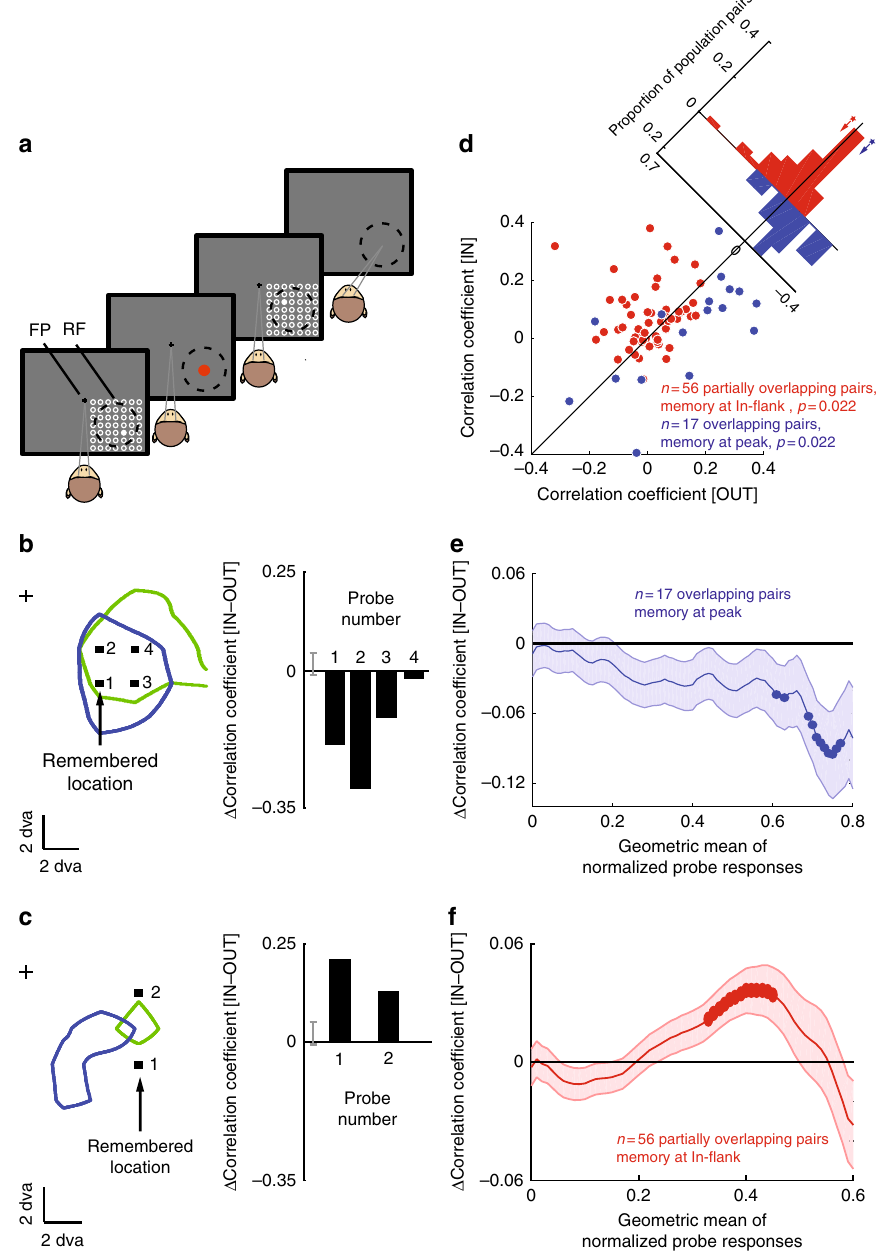
Fig. 4 Changes in noise correlations of visual responses during WM. a MGS task with visual probes. The task was the same as the regular MGS task, except that brief (200 ms) visual probes fl ashed on screen during both the fi xation and delay periods. b Changes in noise correlations of visual responses for an example pair of neurons with overlapping RFs. RF pro fi les (green and blue), probes (black squares), and WM location are shown in visual space relative to the fi xation point (cross). All four probes and WM locations were presented at the Peak location. Bar graphs indicate change in noise correlation (IN – OUT) for the four visual probe locations; for all four probe locations shown, the noise correlation decreased during memory IN. c Changes in noise correlations of visual responses for an example pair of neurons with partially overlapping RFs. Conventions as in b . The two probes and WM locations were presented at the In- fl ank location. Bar graphs indicate change in noise correlation (IN – OUT) for the two visual probe locations: the noise correlation increased during memory IN compared to OUT. d For neurons with overlapping RFs (blue), noise correlations of visual responses decreased when remembering a Peak location ( n = 17 pairs, p = 0.022). For neurons with partially overlapping RFs (red), noise correlations of the visual responses increased when remembering an In- fl ank location ( n = 56 pairs, p = 0.022). e Changes in noise correlation as a function of visual probe location: for overlapping pairs of neurons, remembering a target in the Peak location decreases the noise correlation for probes appearing at Peak RF locations. Probe location ( x -axis) here and in ( f ) is plotted according to the geometric mean of the two normalized RF pro fi le responses at that location ffiffiffiffiffiffiffiffiffiffiffiffiffiffiffiffiffiffiffiffiffiffiffiffiffiffiffiffiffiffiffiffiffiffiffiffiffiffiffiffiffiffiffiffiffiffiffiffiffiffiffiffiffiffiffiffi p ð Þ . Neuron pairs are plotted in a 0.3 wide bin ( x -axis); areas in bold had a signi fi cant effect of memory location on noise RF1response (cid:1) RF2response correlation ( p < 0.05). f Changes in noise correlation as a function of visual probe location: for partially overlapping pairs of neurons, remembering a target in the In- fl ank location increases the noise correlation for probes appearing at In- fl ank RF